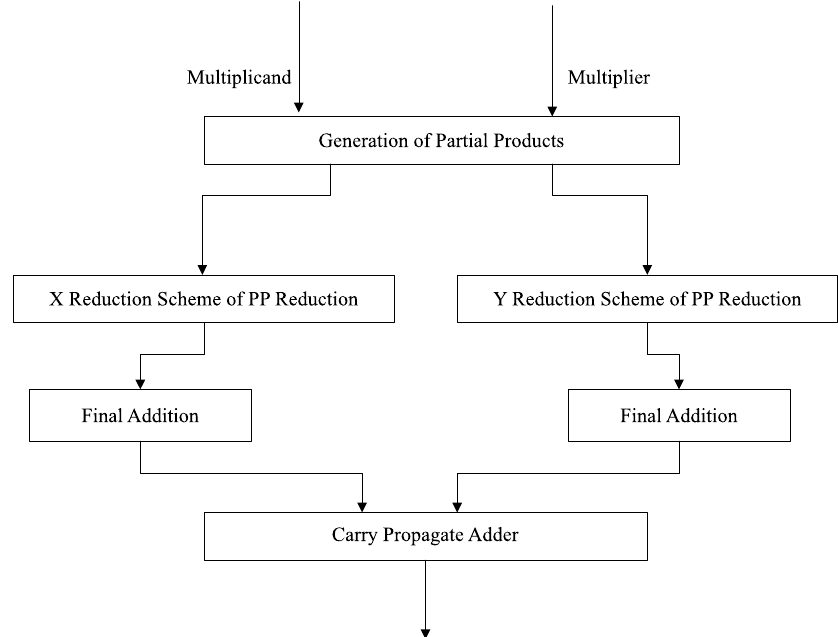
FIG. 6. PROPOSED ARCHITECTURE OF 8 X 8 HYBRID